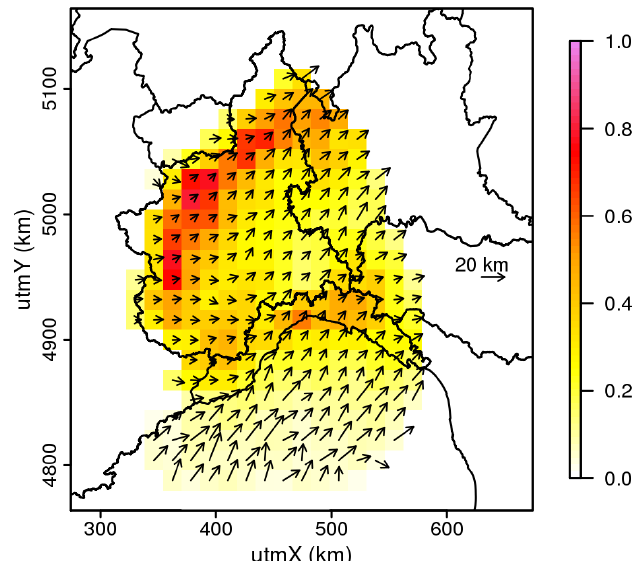
Figure 13. Spatial distribution of mean IDs density (colors) and track directions (vectors) over North-Western Italy. Arrow lengths represent the mean distance travelled. Averages have been evaluated for each 16 km grid